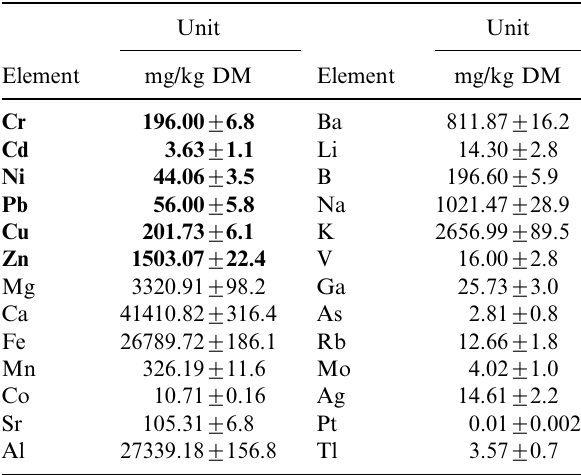
Table 2. Elemental composition of anaerobically digested sewage sludge (ICP-MS